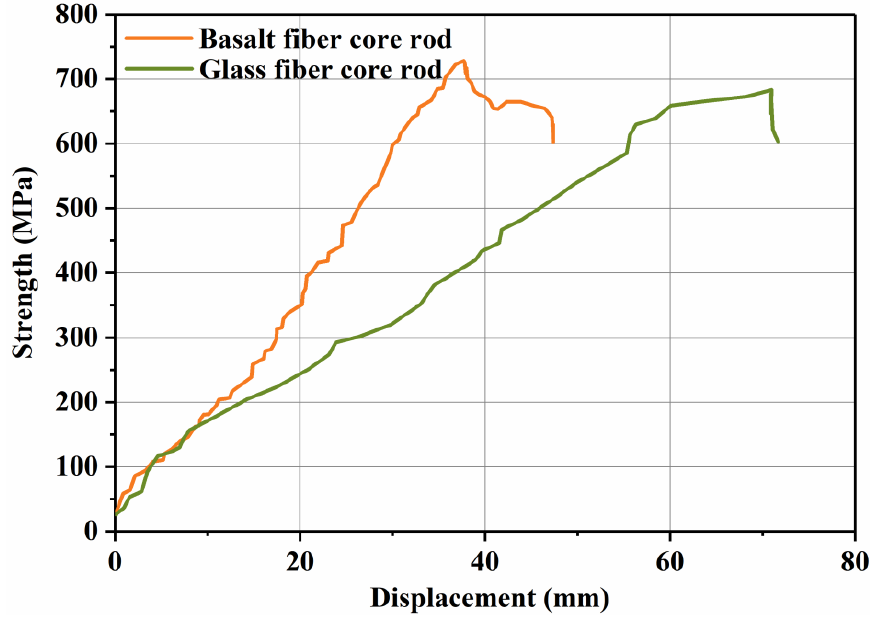
Figure 10. Bending load – displacement curve. Table 1. Comparison of bending parameters between glass fiber core rods and basalt fiber core rods.